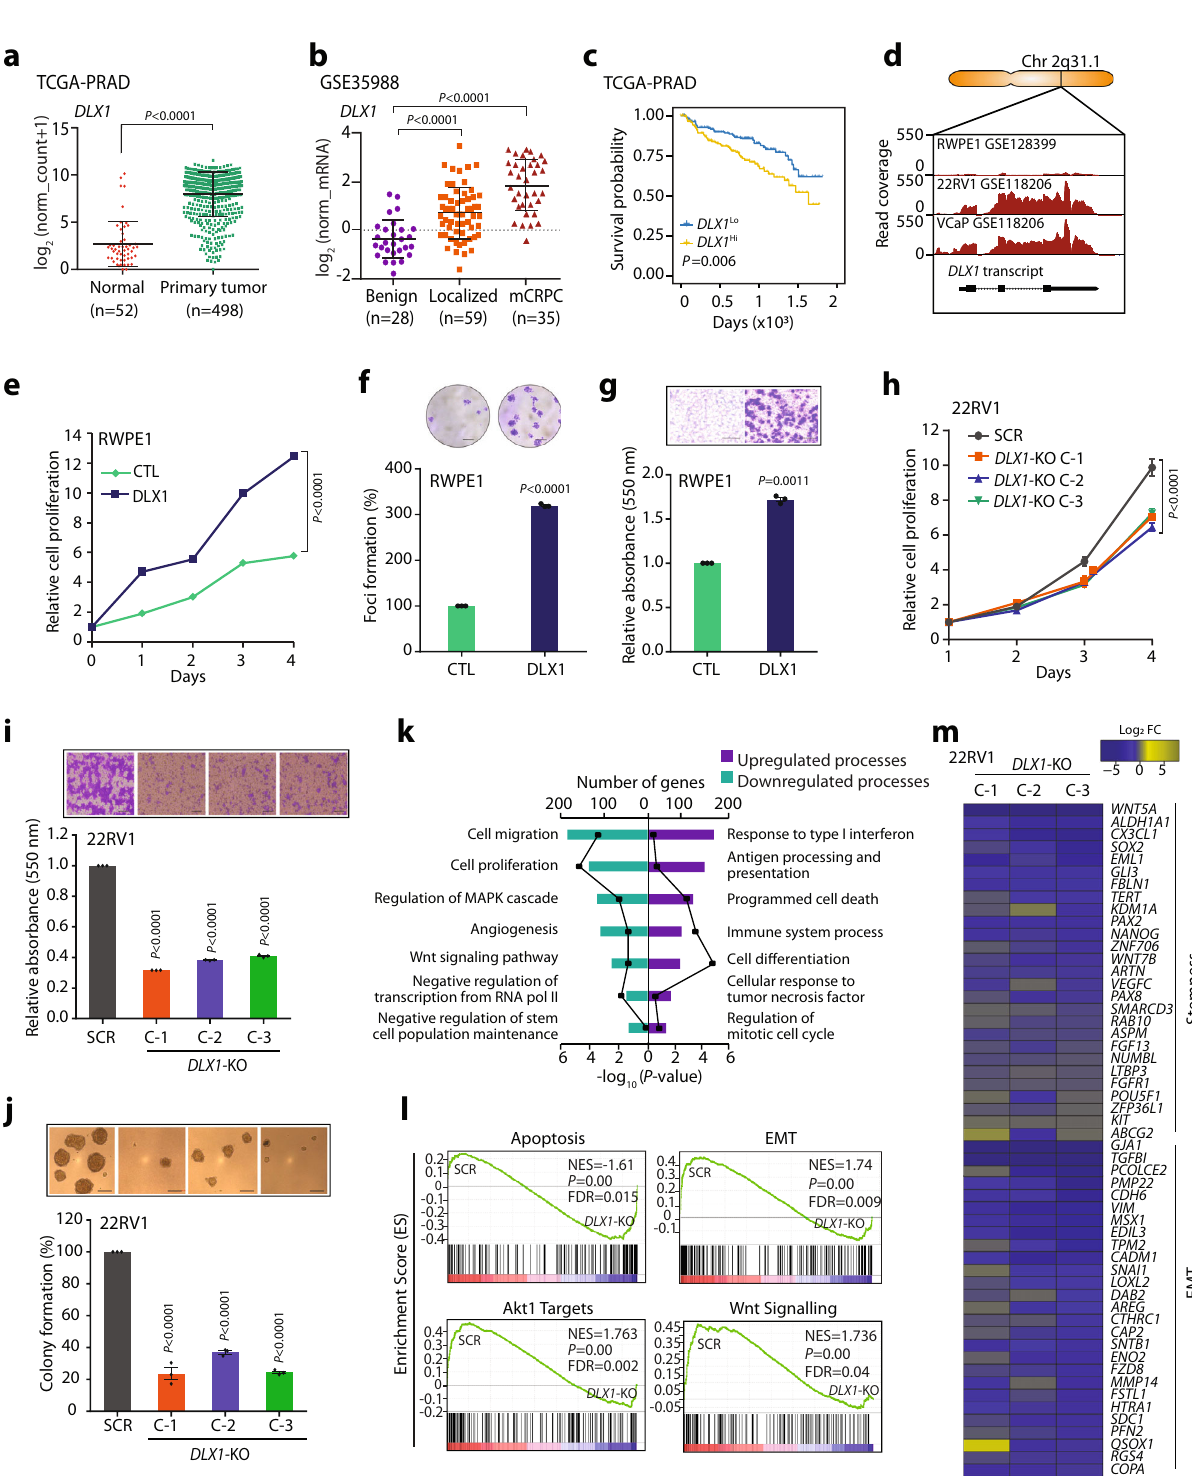
(GSEA) showed enrichment of genes involved in the apoptotic pathway in DLX1 -KO cells, whereas gene sets involved in epithelial-to-mesenchymal transition (EMT), cancer stemness, active Akt, and Wnt signaling were enriched in the control cells (Fig. 1l, m). To further explore the oncogenic role of DLX1 in aggressive PCa, we analyzed RNA-Seq data (GSE78913) 23 for the transient knockdown of DLX1 in LNCaP derivative osteotropic cell line C4-2B, and as speculated DLX1 was found to be one of the top fi ve downregulated genes as depicted in the volcano plot